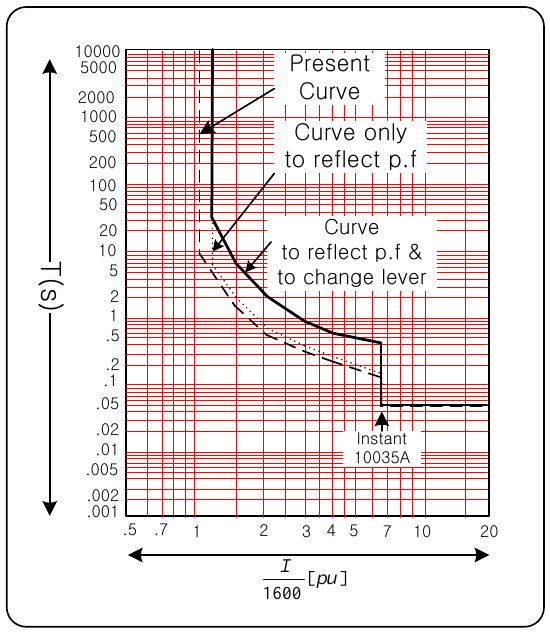
Figure 4. Curves before and after reflecting power factor (pf) and lever.